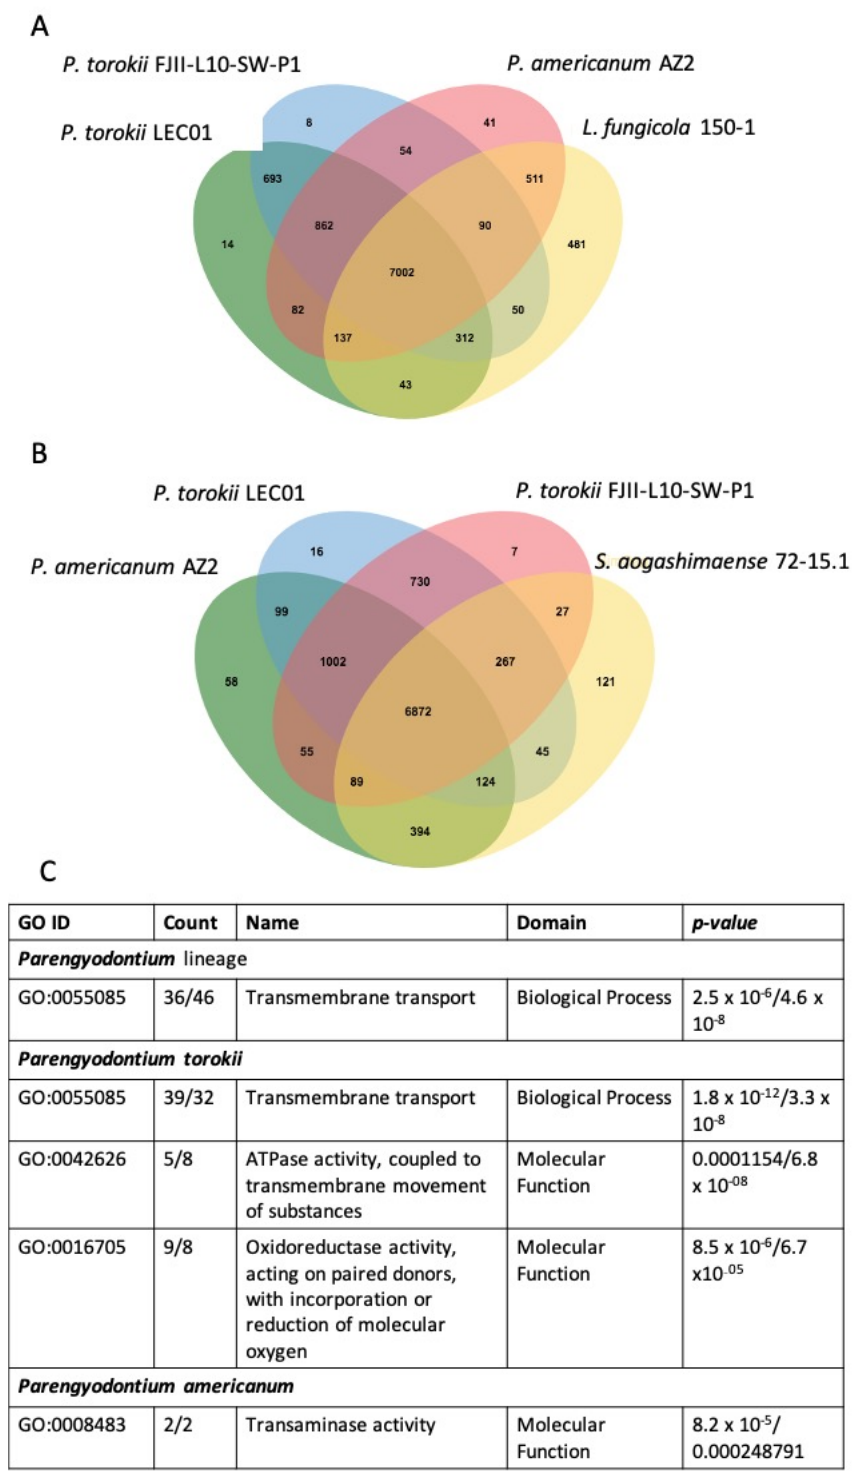
Figure 7. GO-enrichment of the Parengyodontium lineage. The Venn diagram shows shared orthologs and unique groups of genes of the Parengyodontium species using either Lecanicillium fungicola 150-1 ( A ) or Simplicillium aogashimaense 72-15.1 ( B ) as outer species for comparisons. ( C ) The GO categories shared in both scenarios enriched for either Parengyodontium sp., Parengyodontium torokii , or Parengyodontium americanum are listed with its respective function, domain, number of counts, and associated p -value.